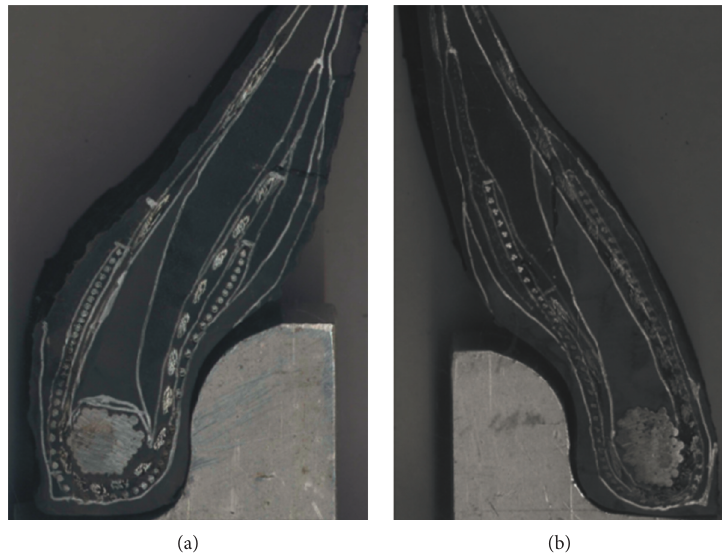
Figure 11: Fatigue failure section of current design and optimized design. (a) Current design. (b) Optimized